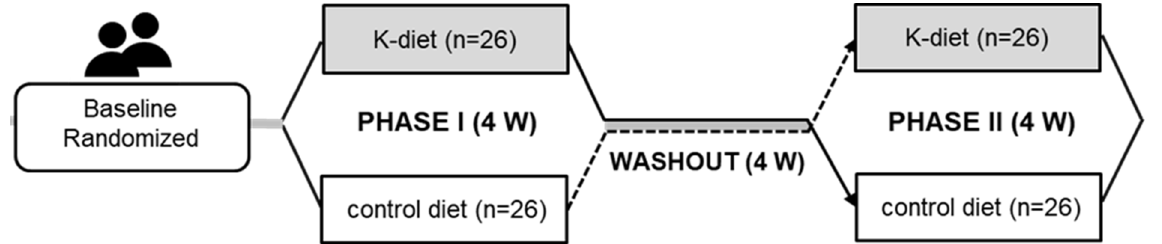
Figure 1. Scheme of the dietary intervention. 4 W, 4 weeks.